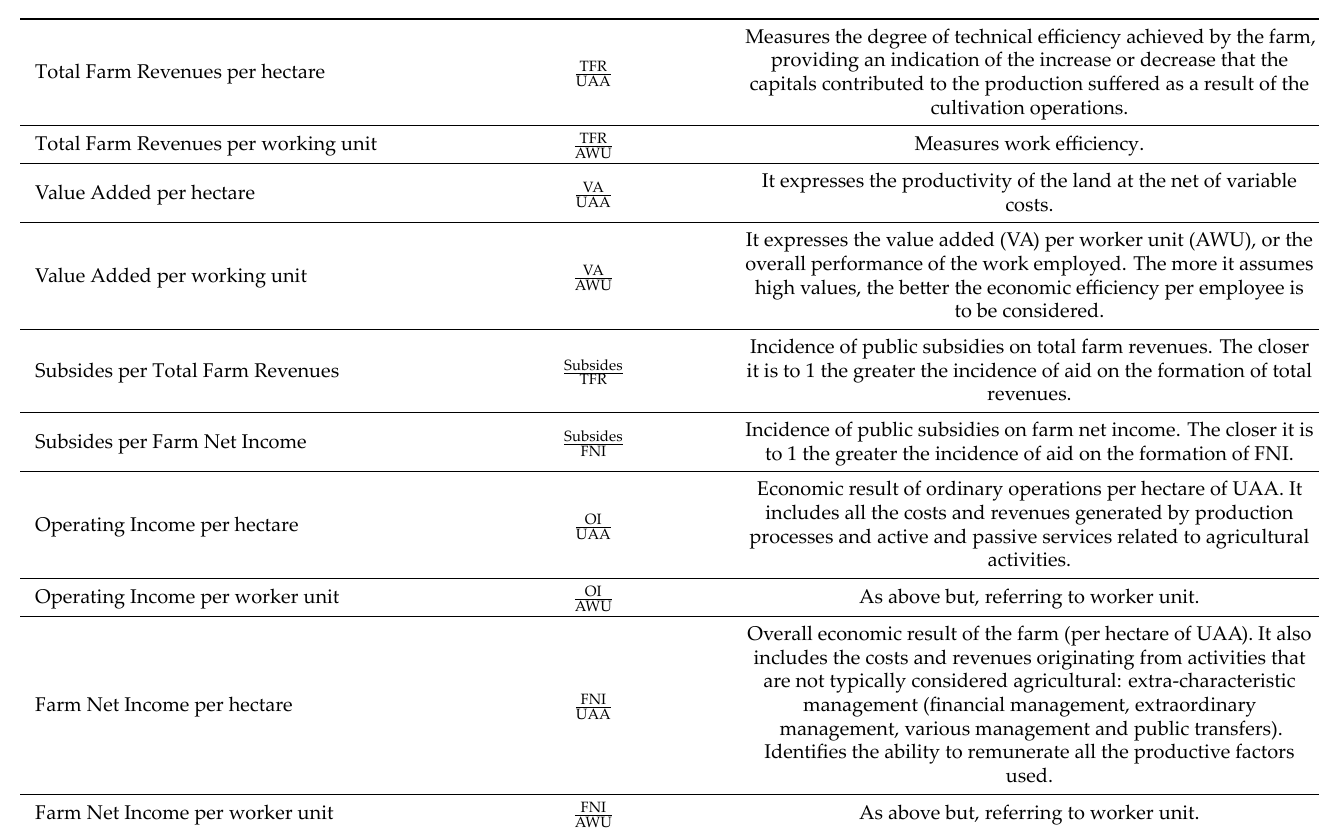
Table A2. Economic indexes used and their brief